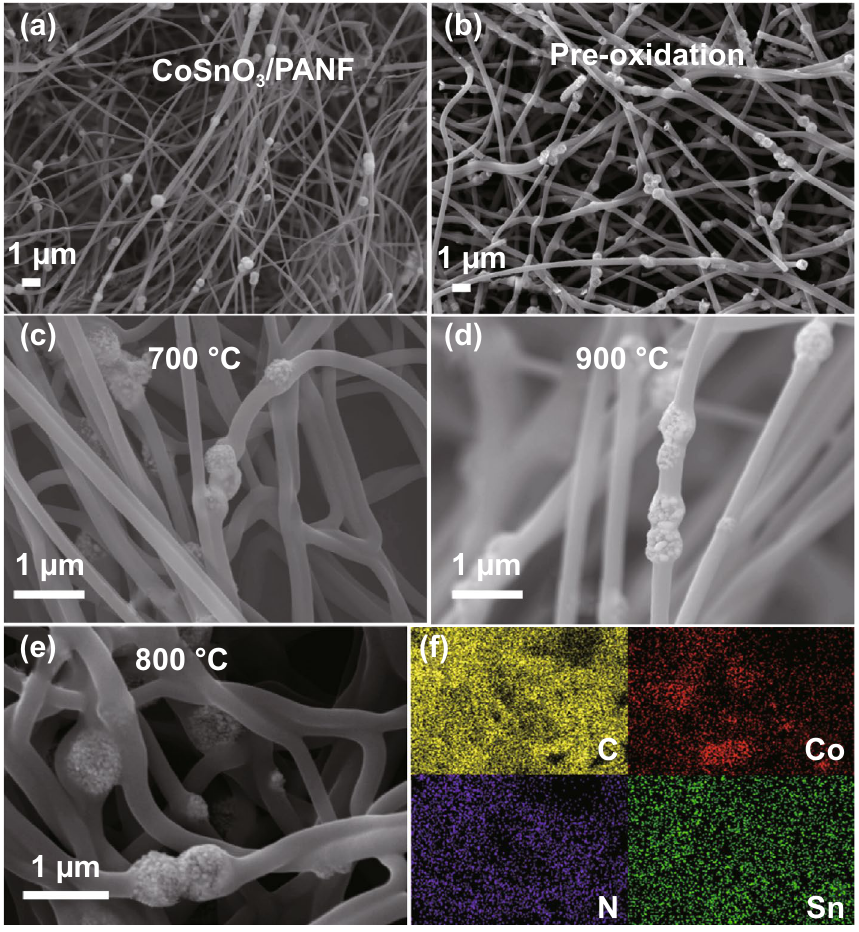
Fig. 3 SEM images of CoSnO 3 /PANF ( a ), CoSnO 3 /PANF after pre-oxidation ( b ), Co 3 SnC 0.7 /CNF-700 ( c ), Co 3 SnC 0.7 /CNF-900 ( d ), Co 3 SnC 0.7 / CNF-800 ( e ); the element mapping of Co 3 SnC 0.7 /CNF-800 ( f